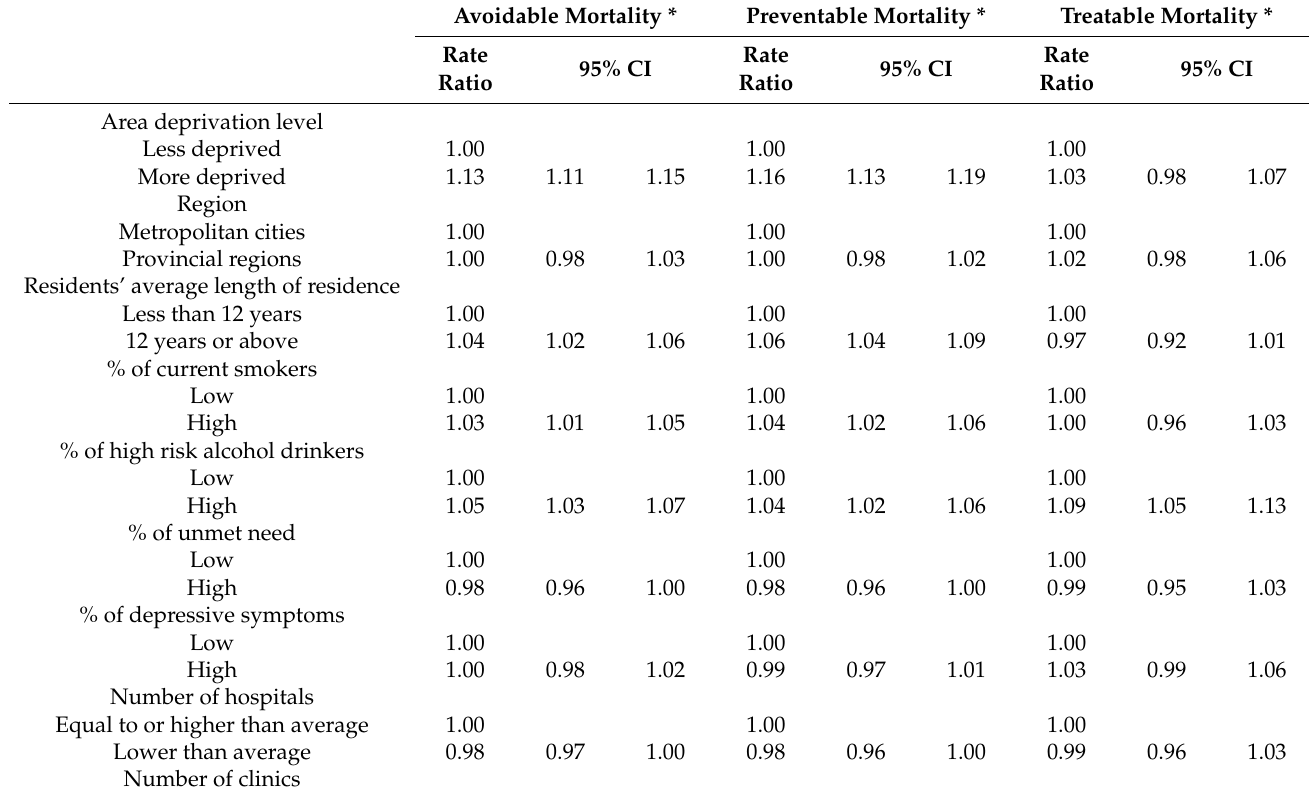
Table 3. The association between cancer-related avoidable, preventable, and treatable mortality and area deprivation